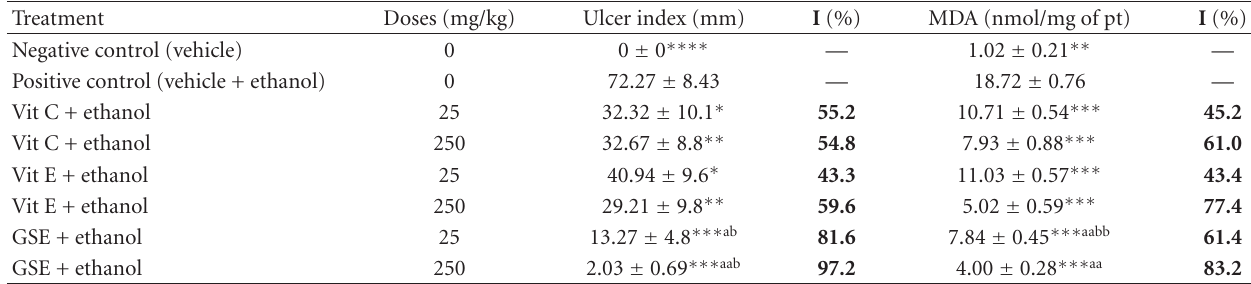
Table 2: E ff ects of GSE, VC, and VE on ulcer indexes and MDA gastric concentrations in rats with ethanol-induced ulcer.